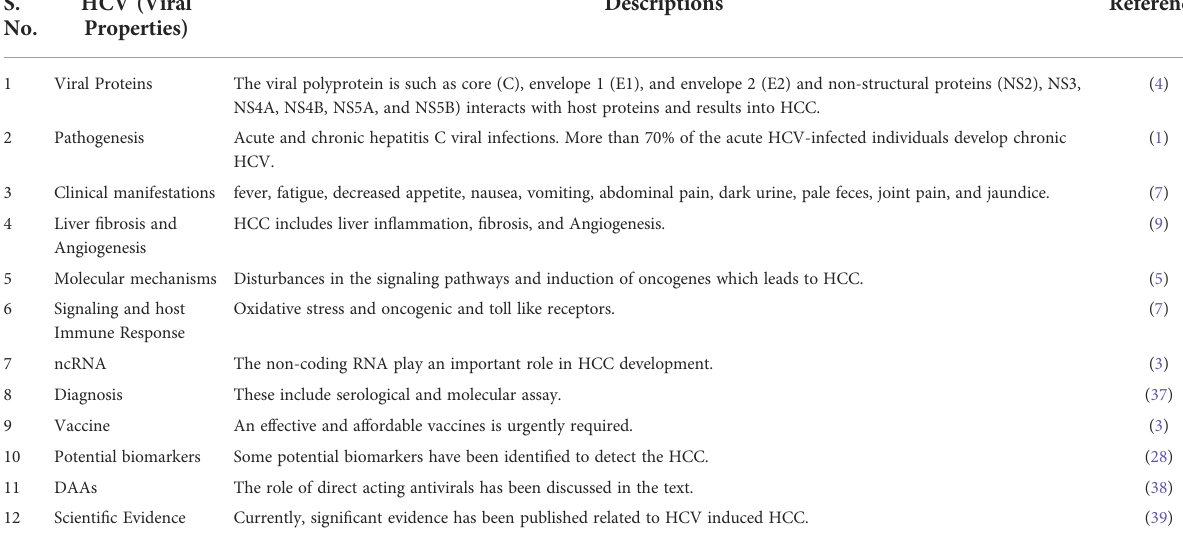
TABLE 1 Association of HCV in the development of Hepatocellular Carcinoma (HCC). S.